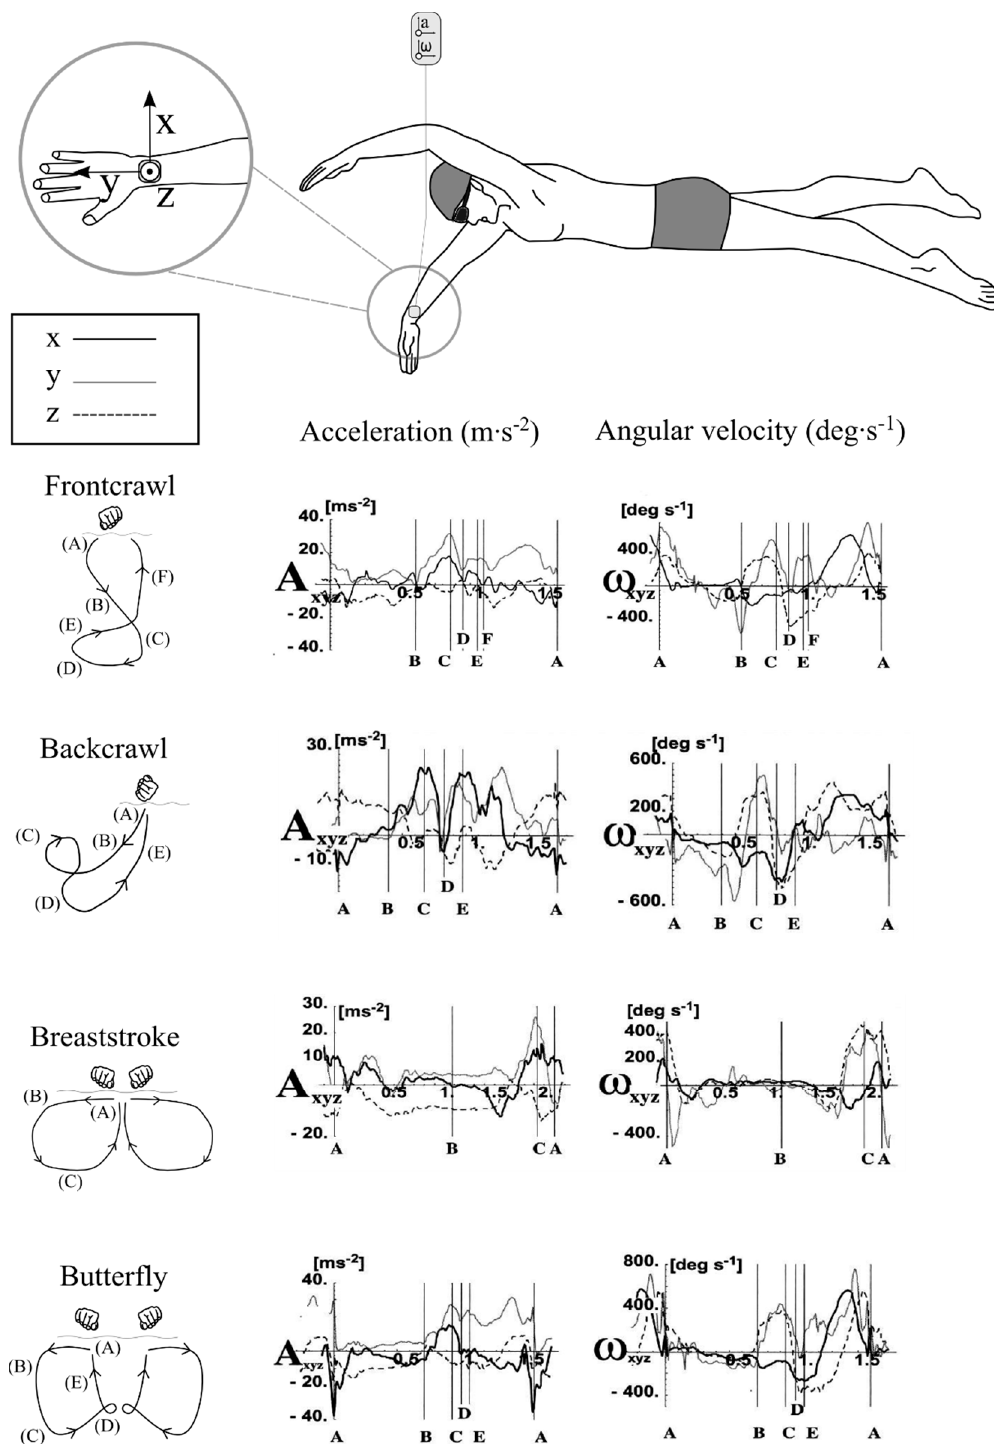
Figure 5. Different swimming styles will exhibit different acceleration (A) and angular velocity ( ω ) patterns. Representative signal output from the wrist is shown. Each signal begins from the point of hand entry into the water and the various phases of each stroke style are identified with vertical lines. Characteristic features of each signal allow researchers extract key performance related information. Adapted from Maglischo [1] and Ohgi [20].